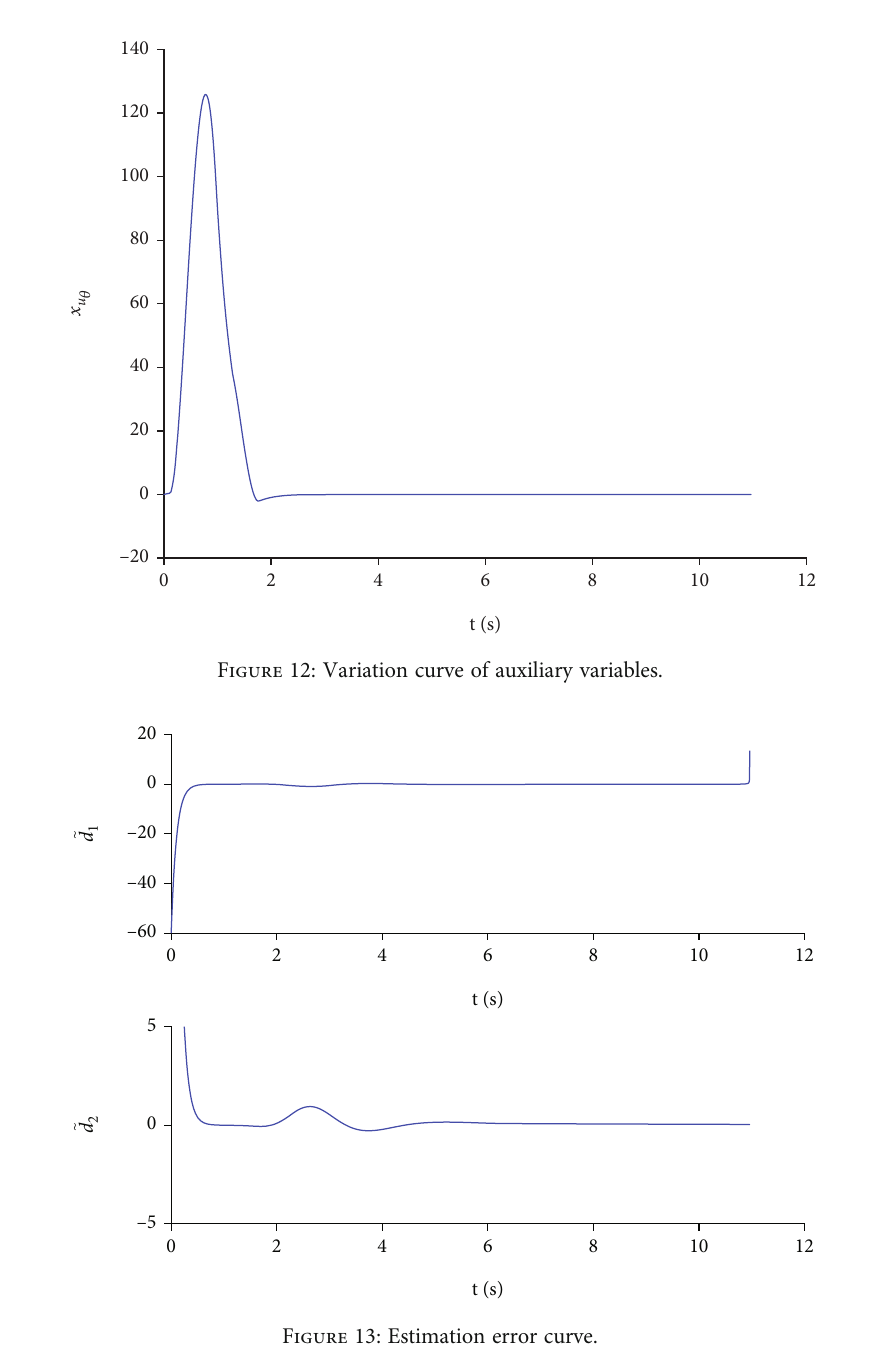
Figure 13: Estimation error